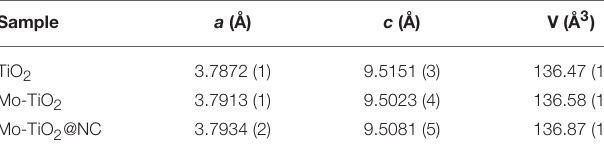
TABLE 1 | The lattice parameters and volume of TiO 2 , Mo-TiO 2 , and